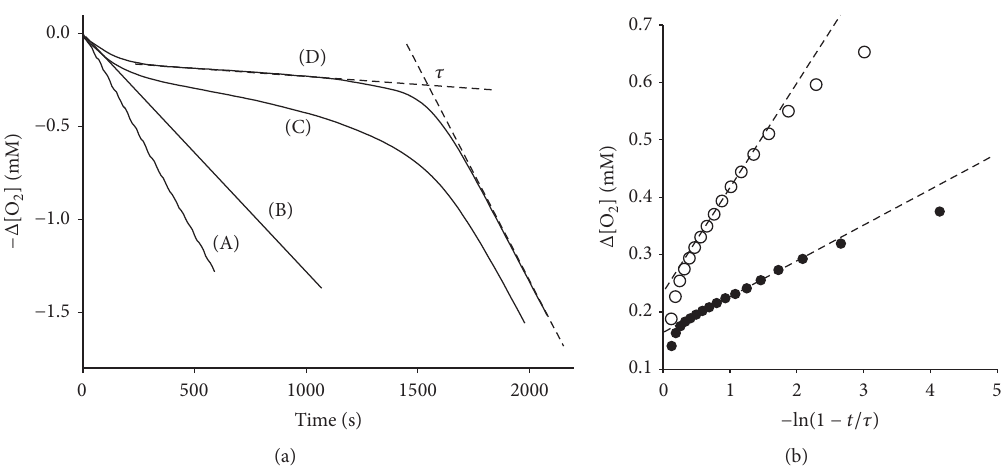
Figure 1: (a) Typical O 2 consumption traces observed during the autoxidation of an organic substrate in the absence (A) or in the presence of antioxidants with low (B), intermediate (C), and high (D) 𝑘 values. (b) Analysis of the O 2 consumption by (6) for the antioxidants having inh intermediate ( ∘ ) and high ( e ) 𝑘 inh